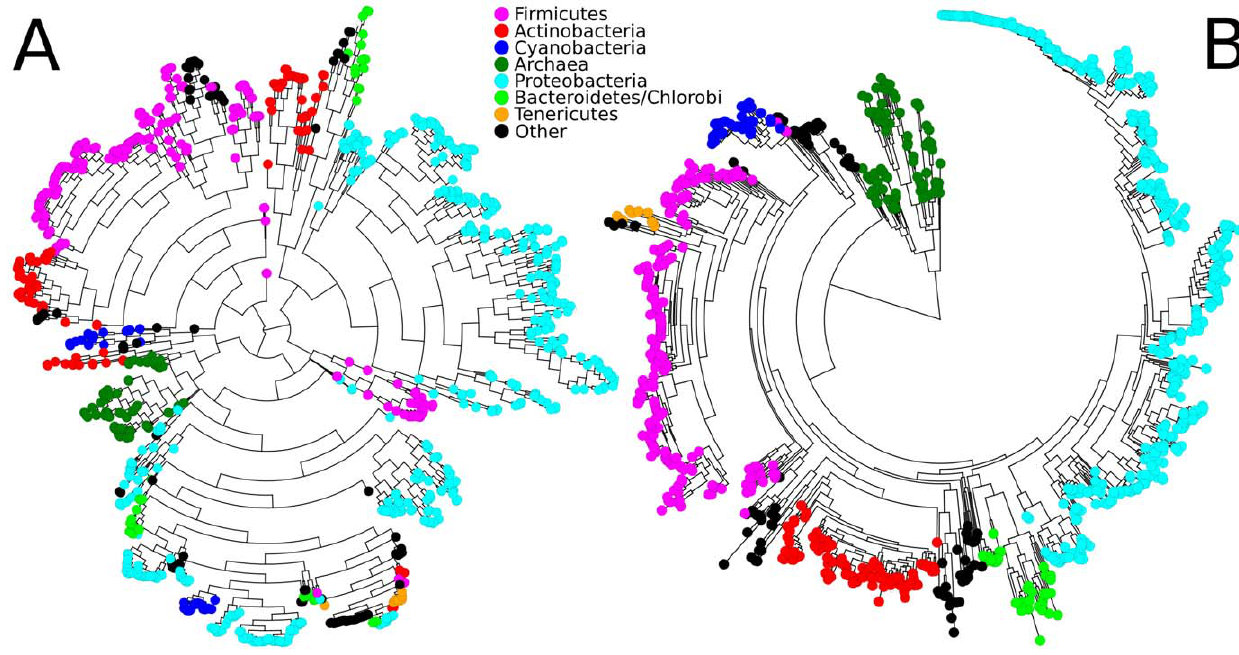
Figure 3. Contrasting a functional phylogeny built using shared gene families with a 16S gene sequence phylogeny. 1,107 sequenced microbes clustered using (A) the cooccurence of COG orthologous gene families (see Figure 2) or (B) 16S gene sequence similarity (using Muscle and FastTree [35]). Phyla from the NCBI Taxonomy are indicated by color. While overall organismal similarities are maintained at both the functional and sequence levels, the two phylogenies provide distinct perspectives on organismal relatedness. Some clades like the Archaea and Firmicutes form very distinct sub-trees, whereas others like Bacteroidetes/Chlorobi , Actinobacteria and Cyanobacteria show high 16S similarity relative to their functional similarity. Figure 3. Specifically, after normalizing the two trees with respect to total branch length, we summarized the trees as all-versus-all